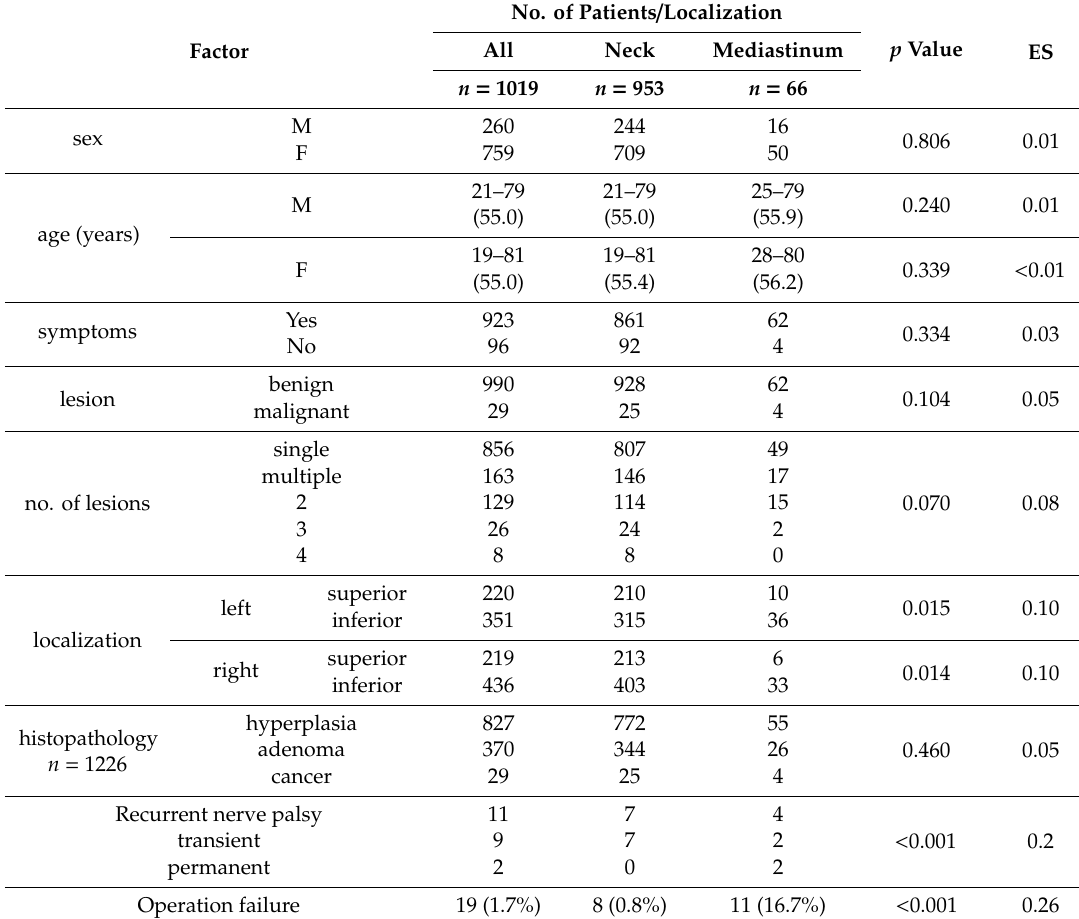
Table 2. Patient’s